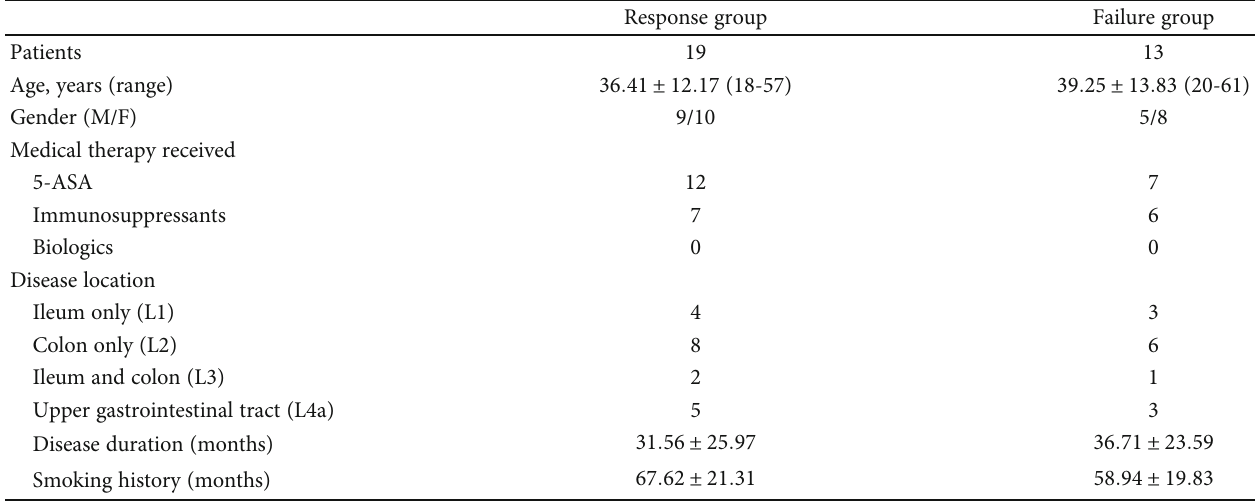
Table 2: The clinical characteristics of active CD